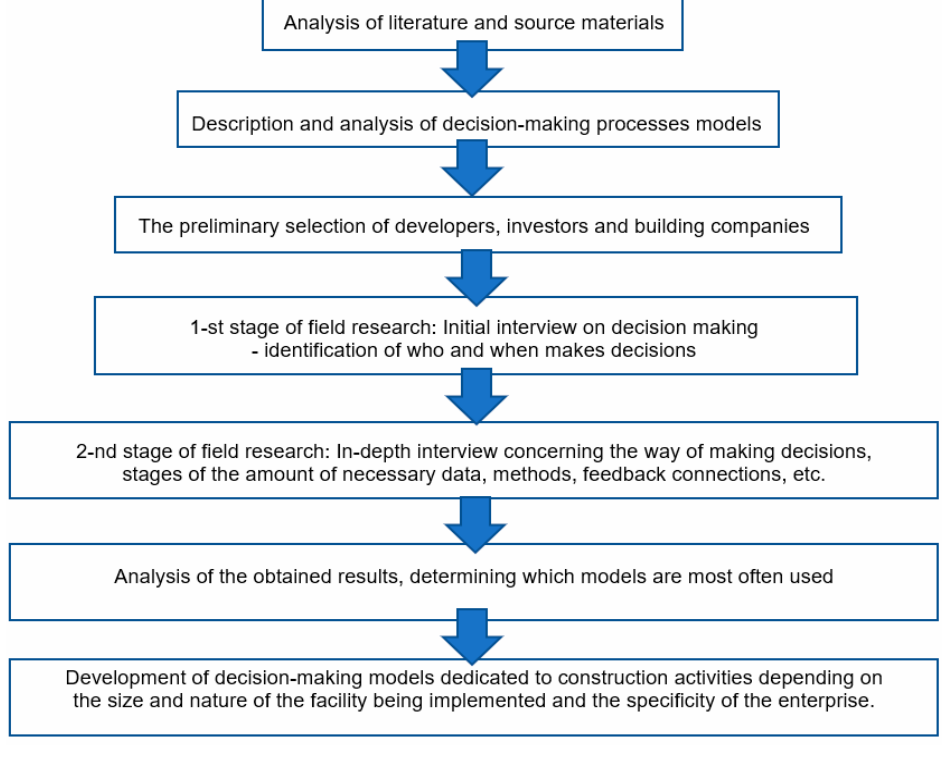
Figure 5. Scheme of research process.